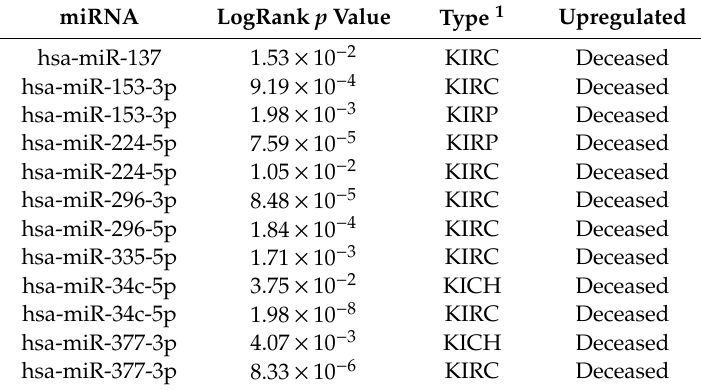
Table 3. The association between miRNA expression and survival outcome.